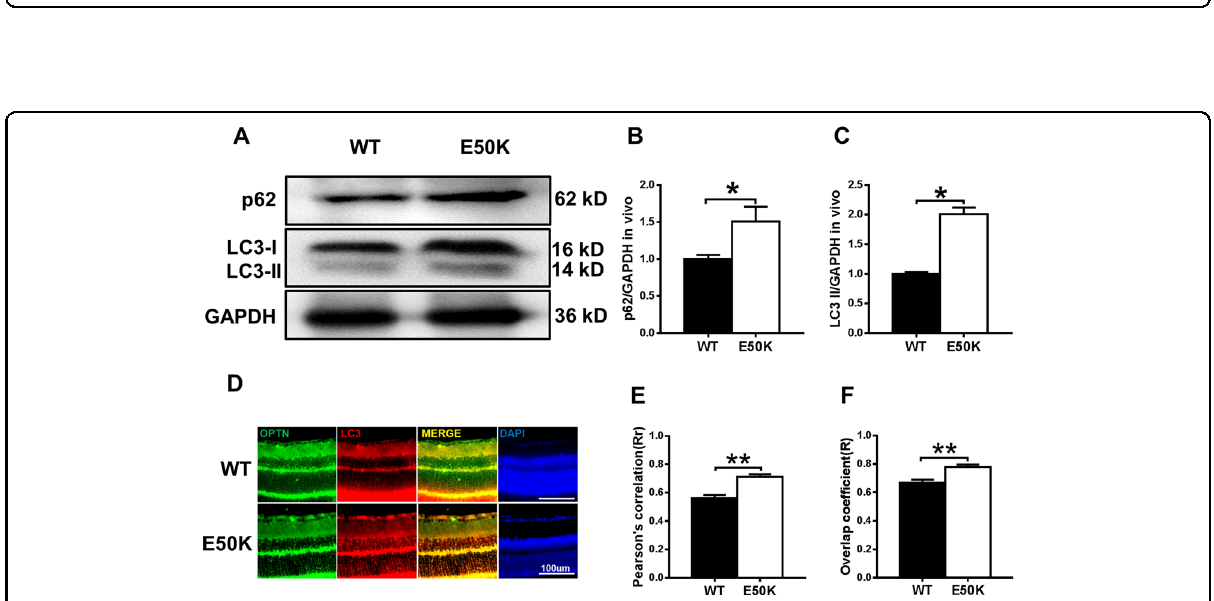
Fig. 4 The OPTN-E50K point mutation affects autophagy and the colocalization of optineurin and LC3. A Western blotting showing endogenous p62/SQSTM1 and LC3 levels in retinas from WT and E50K mutant mice. B Quanti fi cation of p62/SQSTM1 and C LC3 protein expression levels. D Retinal sections were immunostained for optineurin and LC3, and nuclei were stained with DAPI. E , F Quanti fi cation of the percentage of OPTN-LC3 colocalization. n = 19/14. Mean ± SEM. * P < 0.05; ** P < 0.01.